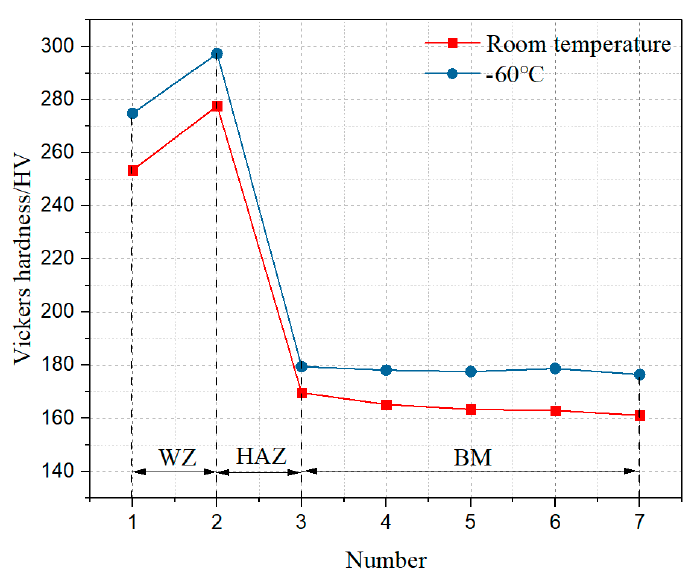
Figure 17. The Vickers hardness of cruciform welded joints at room temperature and − 60 °C.